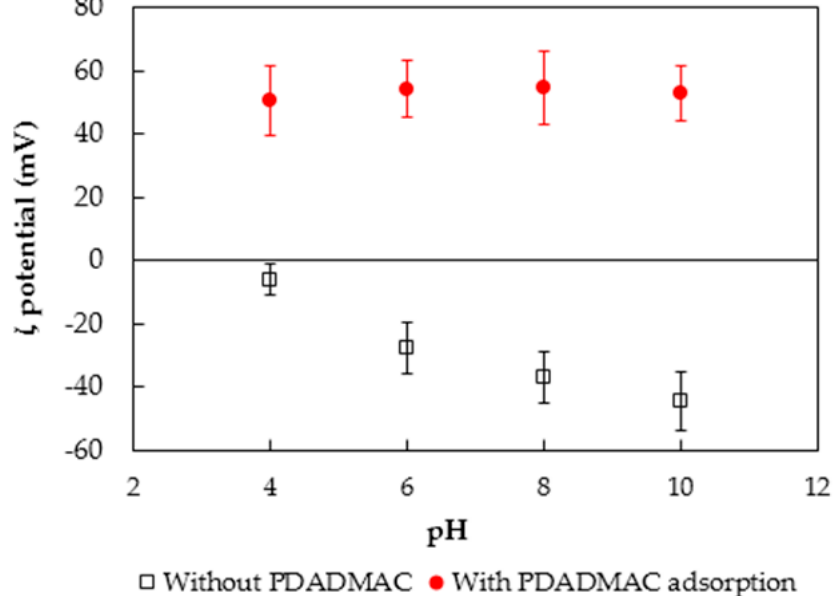
Figure 9. The ζ potentials of nanosilica particles without and with PDADMAC adsorption as a function of pH in 1 mM KCl background electrolyte.